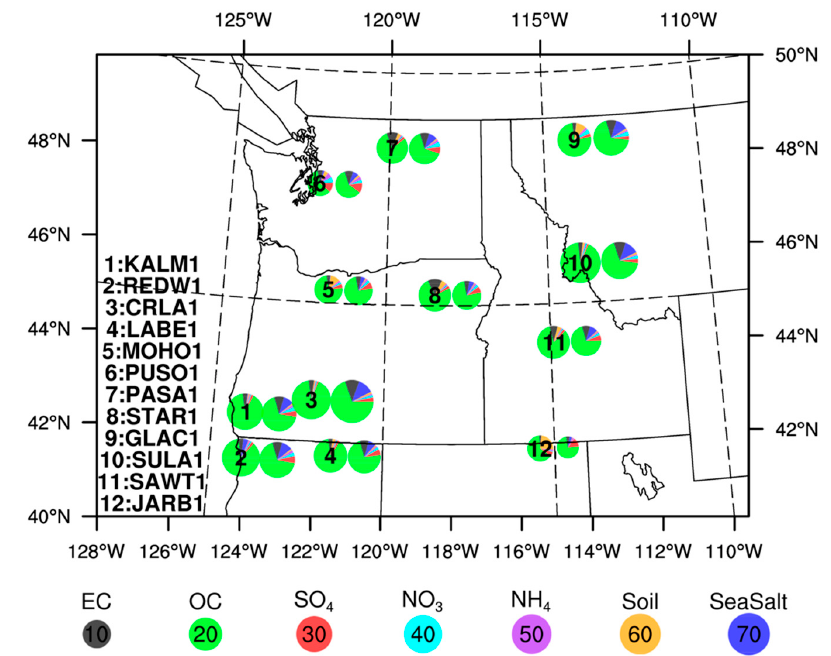
Figure 7. Comparison of PM 2.5 concentrations and speciation between the IMPROVE ground measurement network (left pie charts with site numbers) and the WRF-CMAQ SENS model simulation (right pie charts without site numbers). The colors in each pie chart denote PM 2.5 chemical compositions and the size of each pie chart denotes bulk PM 2.5 concentrations as shown by the reference numbers in the